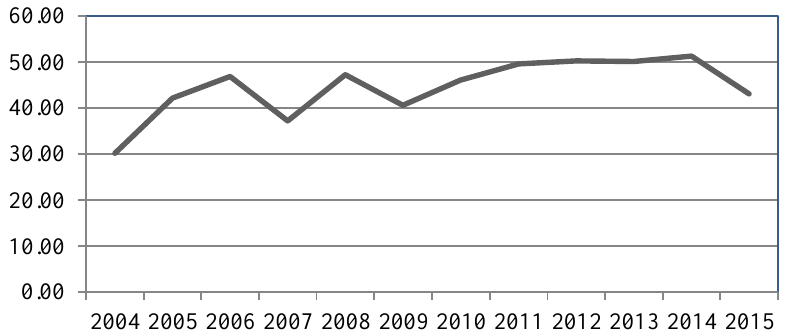
Fig. 6. The share of oil and gas return in the total volume of federal budget revenues for 2004–2015, in % (compiled by the authors to: [20]).